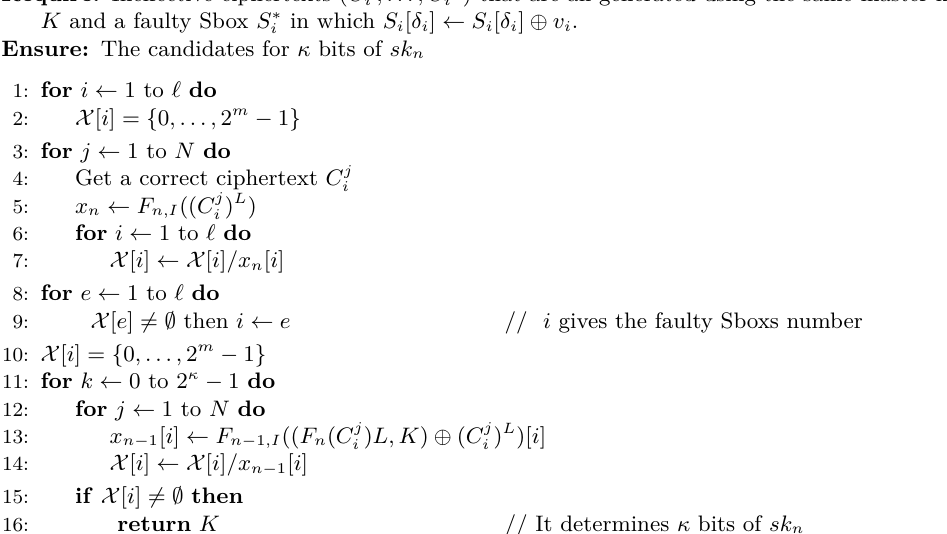
Algorithm 2 Key-recovery on a Feistel cipher with a detection-based countermeasure, assuming that δ and i are i